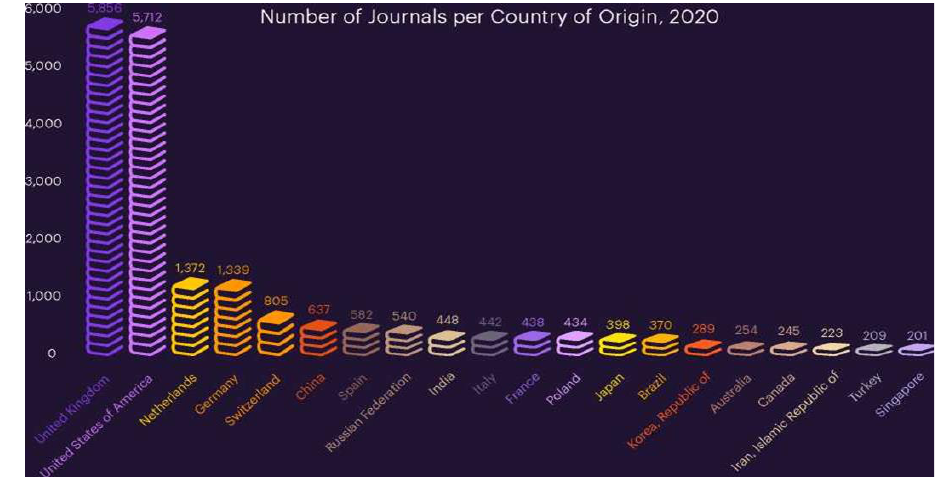
Figure 1. Numbers of Journals per Country 2020